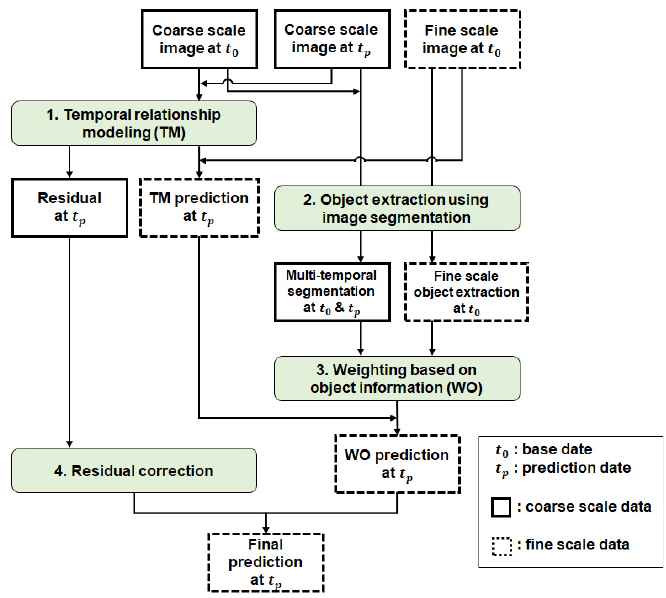
Figure 1. Schematic diagram of four processing steps employed in this study. Blocks in green denote the major steps of HIFOW.